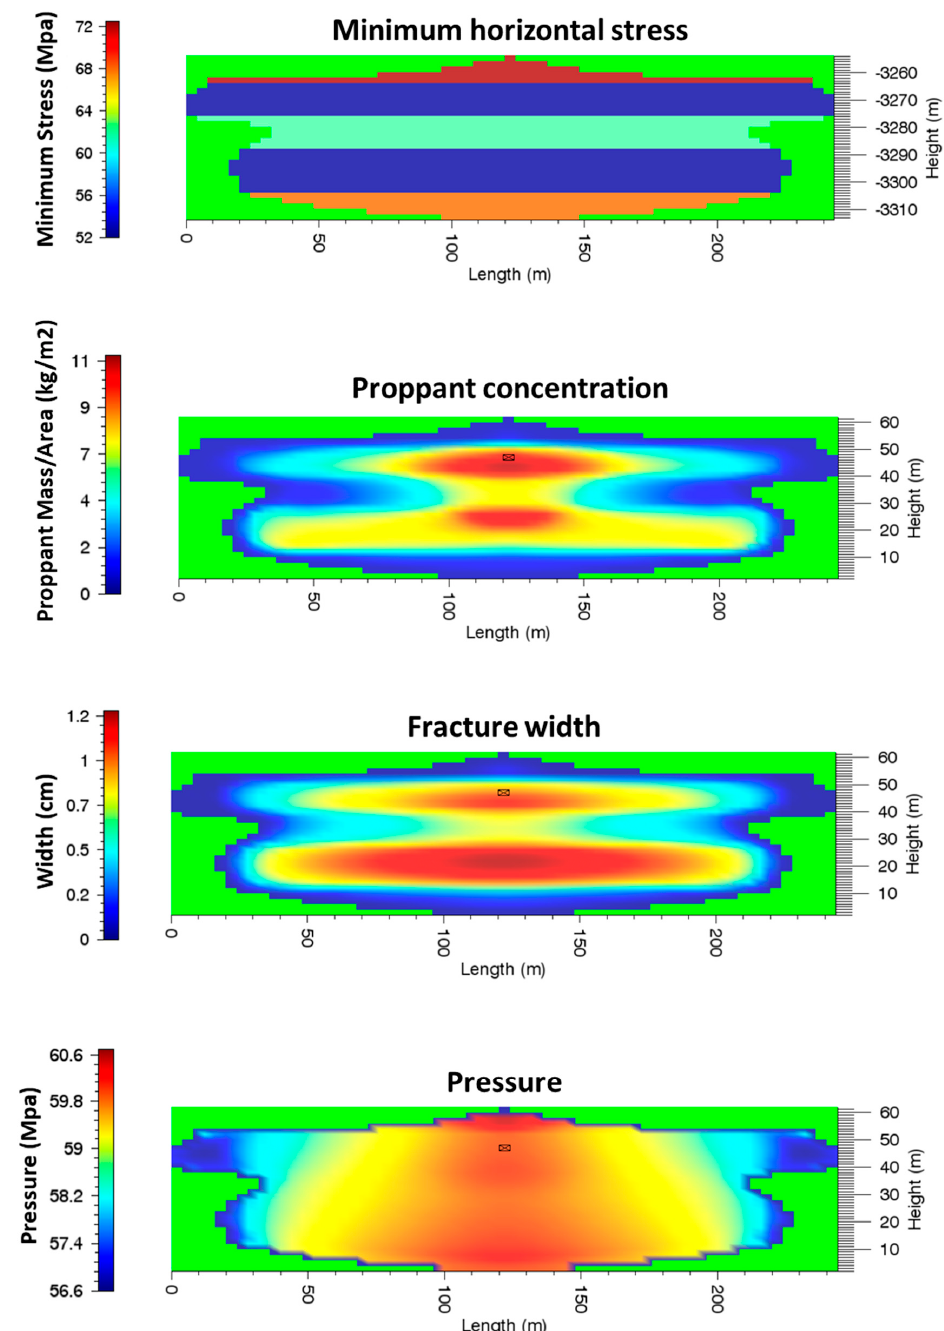
Figure 16. The stress profile, fracture width, proppant concentration and fluid pressure across the fracture of Case 5. fracture of Case